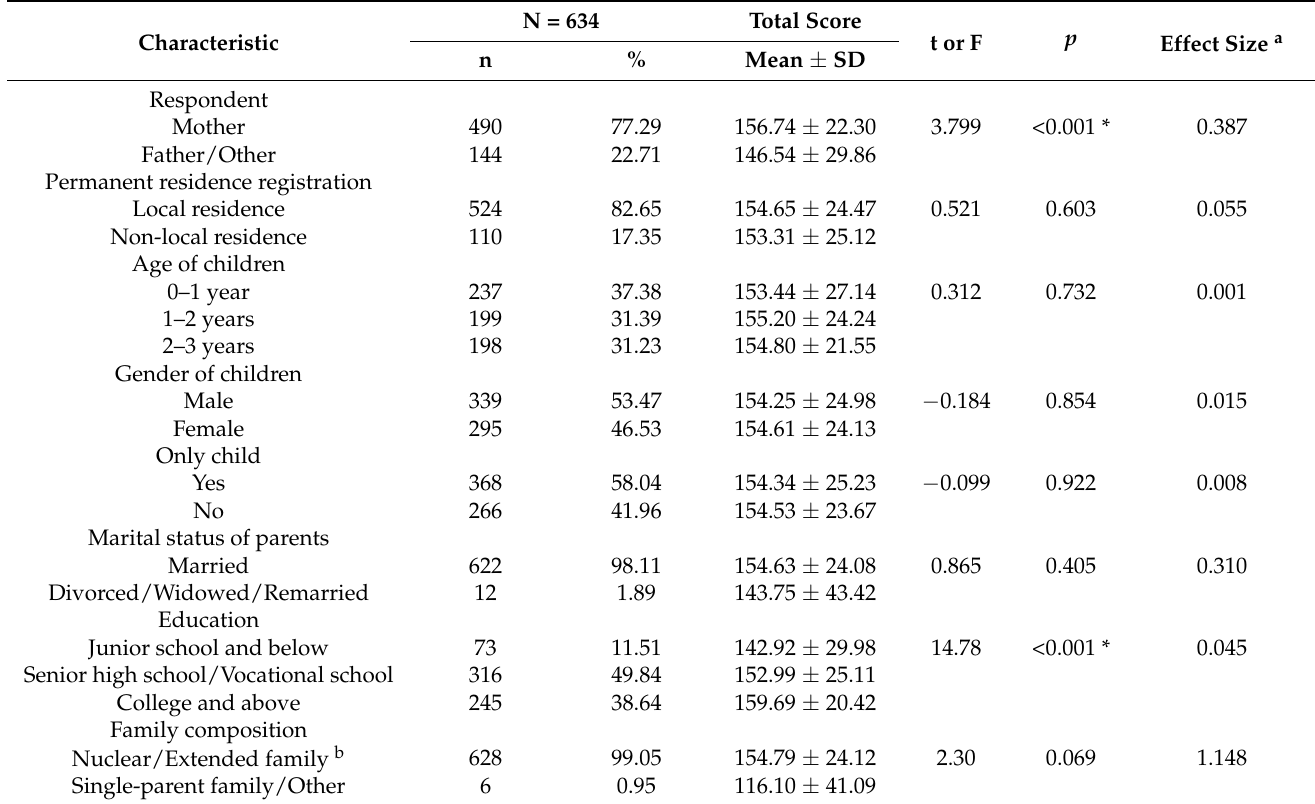
Table 1. General characteristics of caregivers and their children (N =